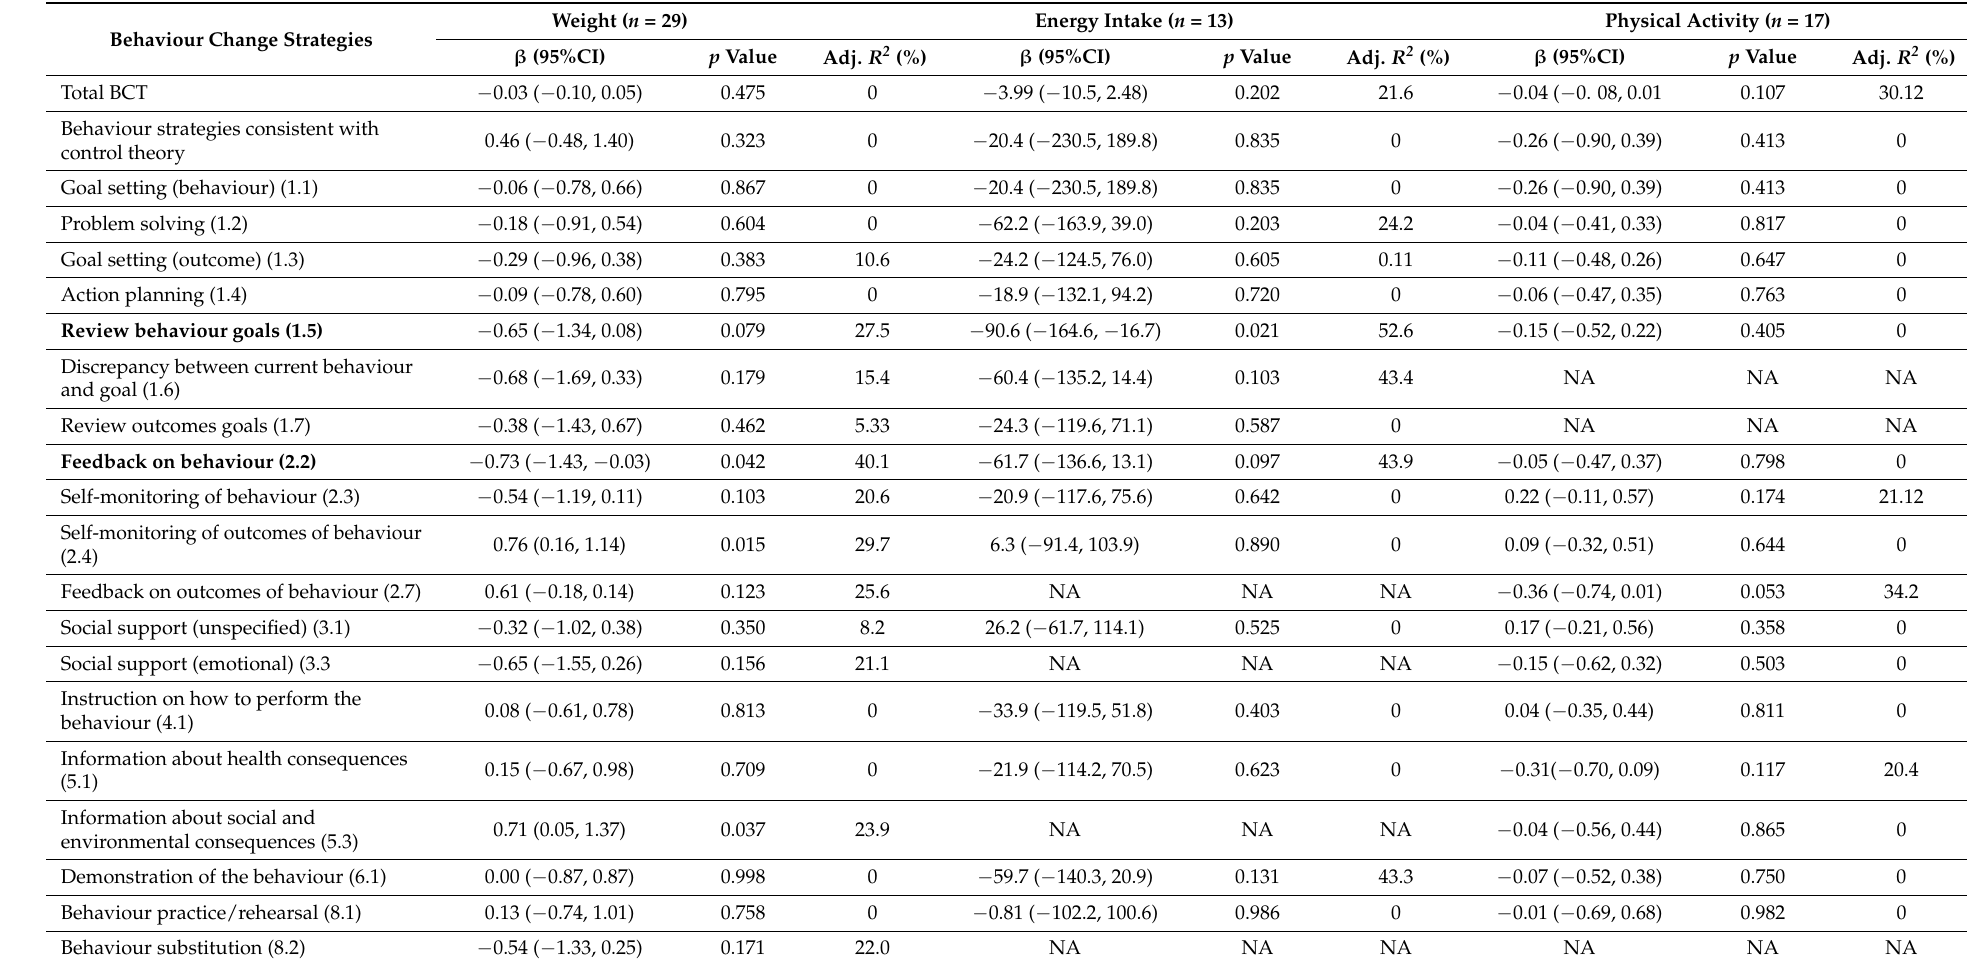
Table 1. Univariable meta-regression results for weight and energy intake by behaviour change